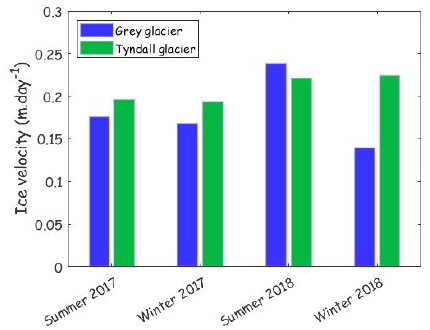
Figure 11. Mean ice velocity for each image pair.